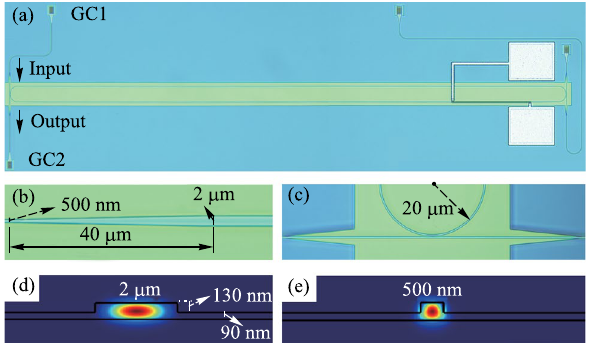
Fig. 2 Micrographs of the fabricated MRR and simulated power dis- tribution of the fundamental TE mode of MRR. a Global view of the MRR (GC: grating coupler). b Zoom-in view of the linear taper. c Zoom-in view of the coupling region. Simulated power distribution of the fundamental TE mode for d the 2 μm width ridge waveguide and e the 500 nm width ridge waveguide